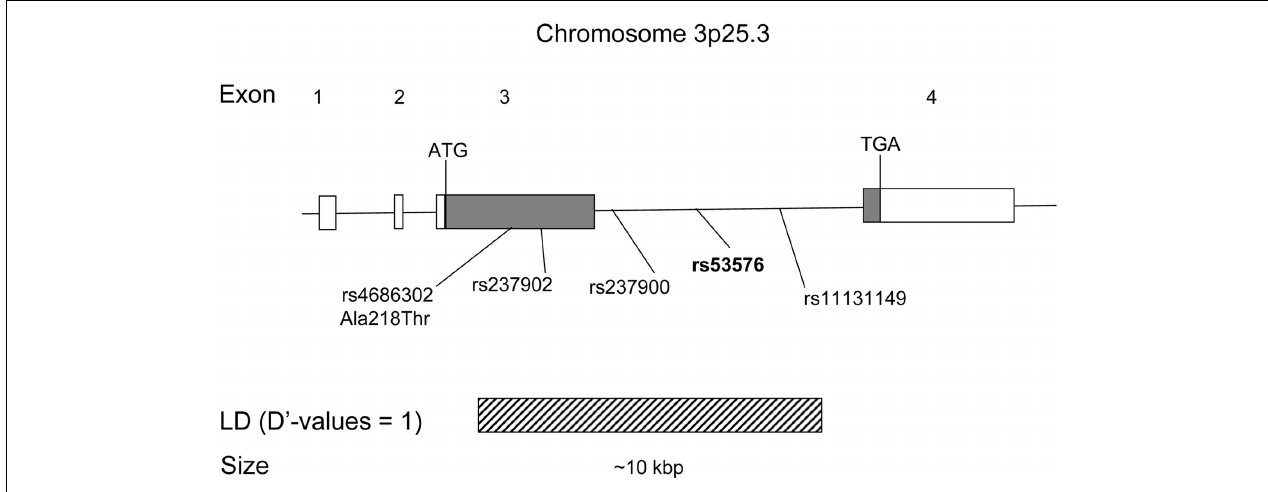
FIGURE 1 | Schematic of the human OXTR gene. Showing location of the four exons, the five SNP marker positions (including rs53576), and known LD block (from HapMap data release February 27, 2009, NCBI B36 assembly).